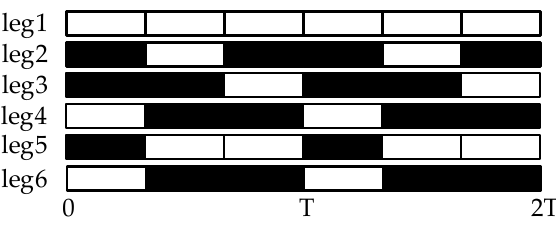
Figure 5. Phase sequence table of F-TT gait in leg 1 fault state.